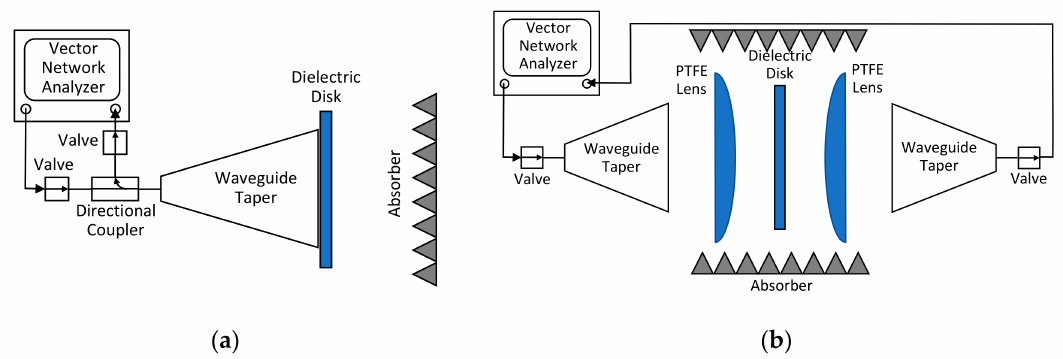
Figure 4. Schematics of the setups used to measure the dielectric disks parameters: ( a ) reflection measurements; ( b ) trans- mission